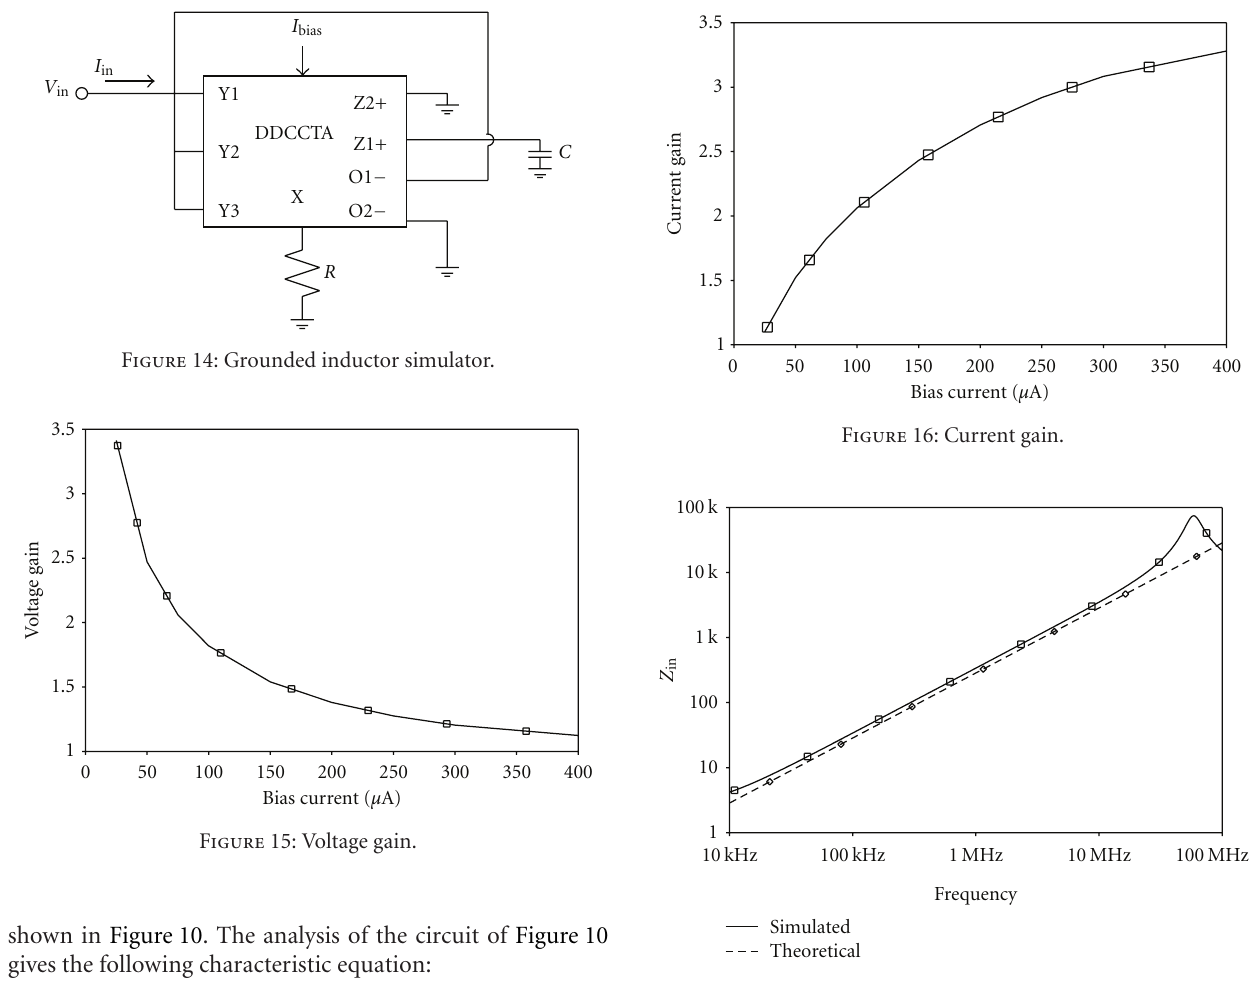
Figure 17: Frequency response of grounded